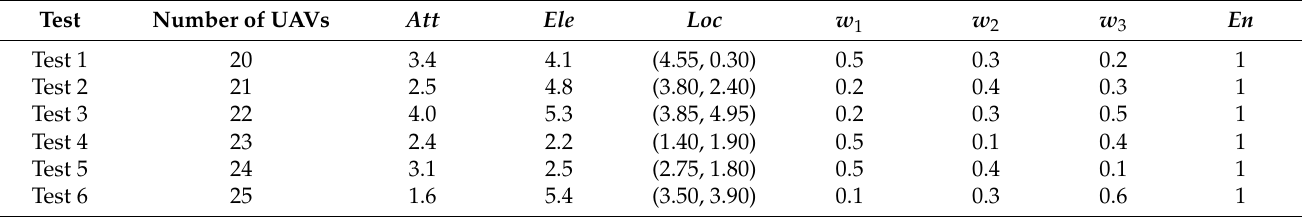
Table 9. Mission settings in small-scale